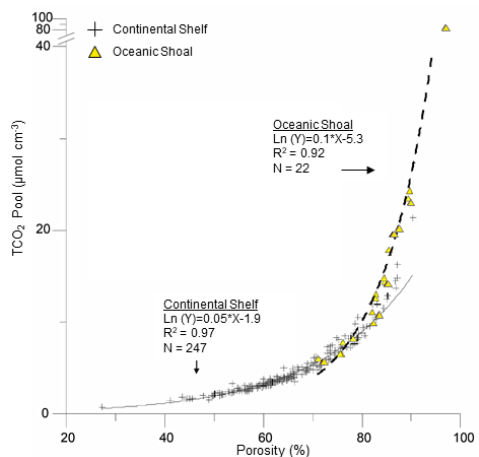
Figure 11. Total carbon dioxide porewater pool concentration (0–2 cm) versus porosity (0–2cm) of the samples collected on the Australian Shelf between October 2007 to May 2013 (see Table 1 in [39] for survey details). The yellow triangles pertain to pockmarked sediment in the Oceanic Shoals AMP survey areas.